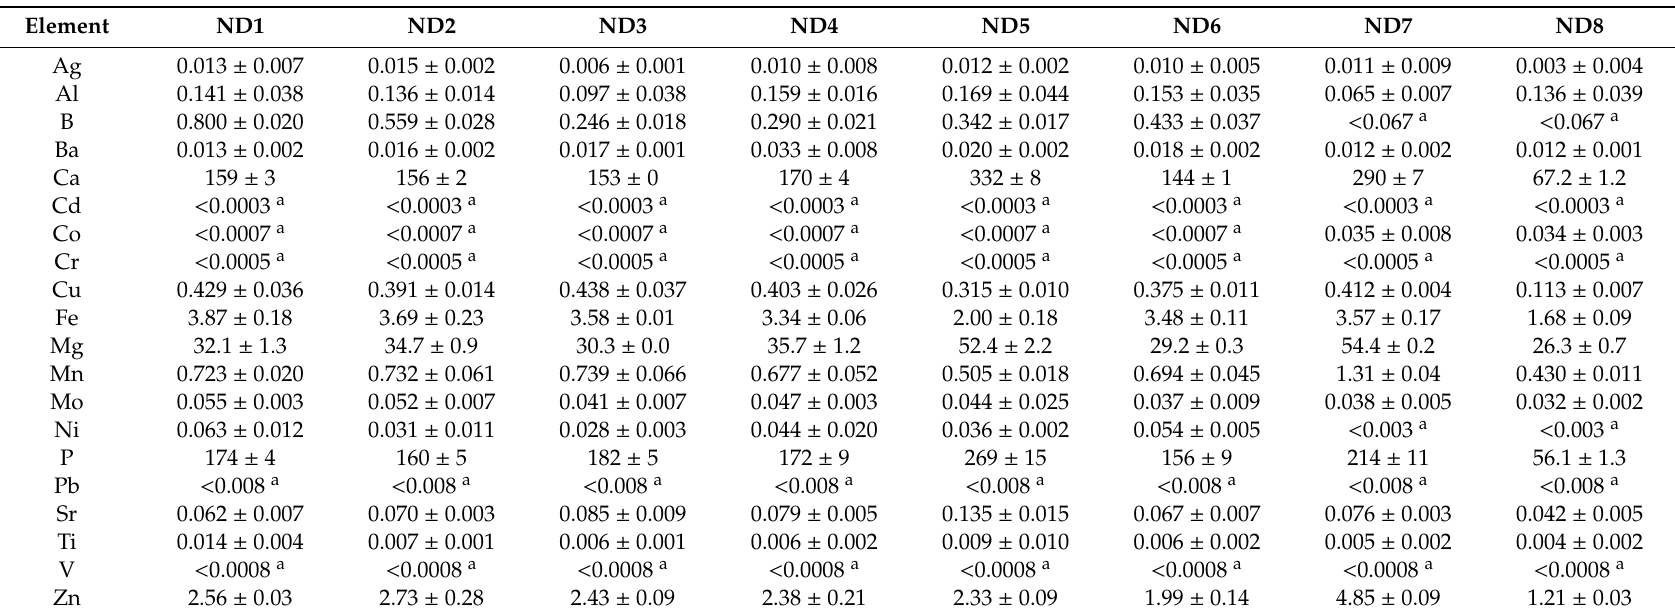
Table 2. Concentrations of studied elements in nutritional drinks (NDs) in mg per 100 mL of the original